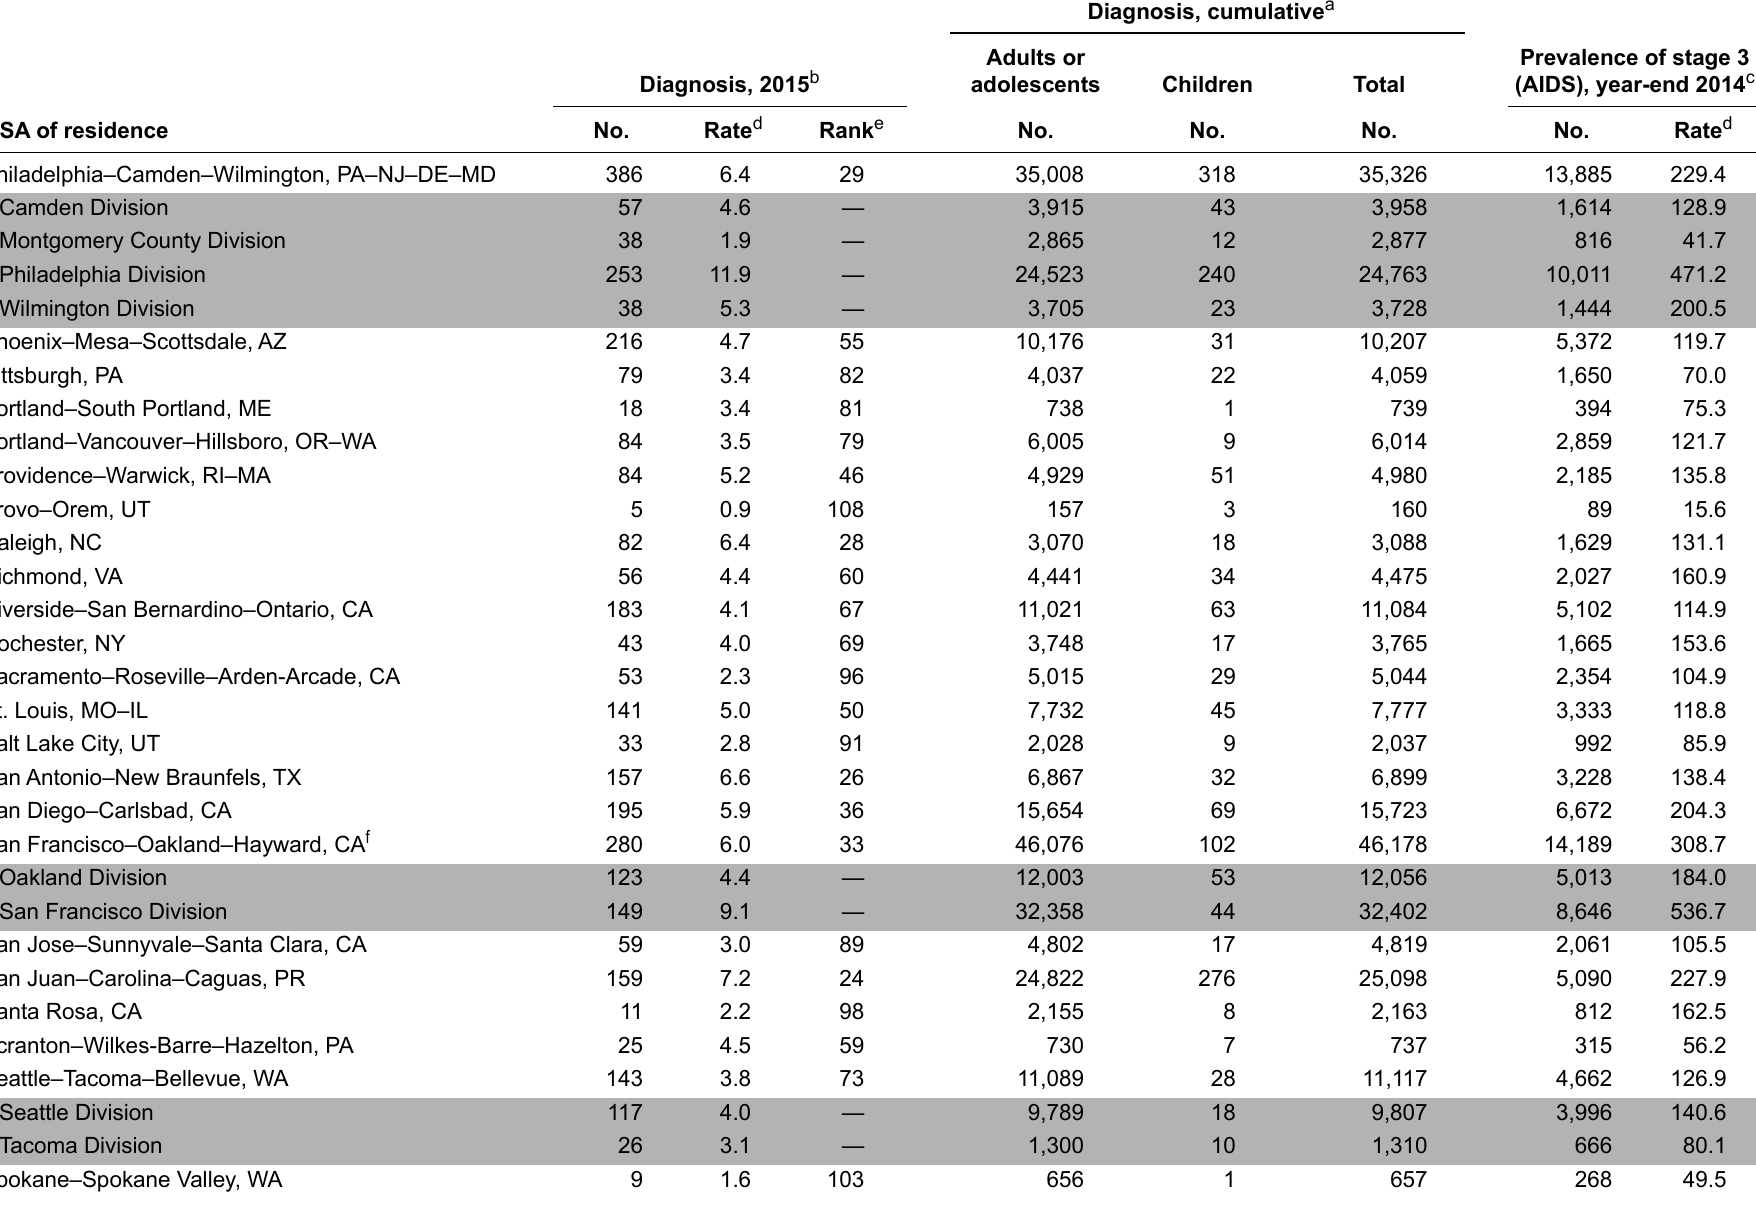
Table 27. Stage 3 (AIDS), 2015 and cumulative, and persons living with diagnosed HIV infection ever classified as stage 3 (AIDS) (prevalence), year-end 2014, by metropolitan statistical area of residence—United States and Puerto Rico